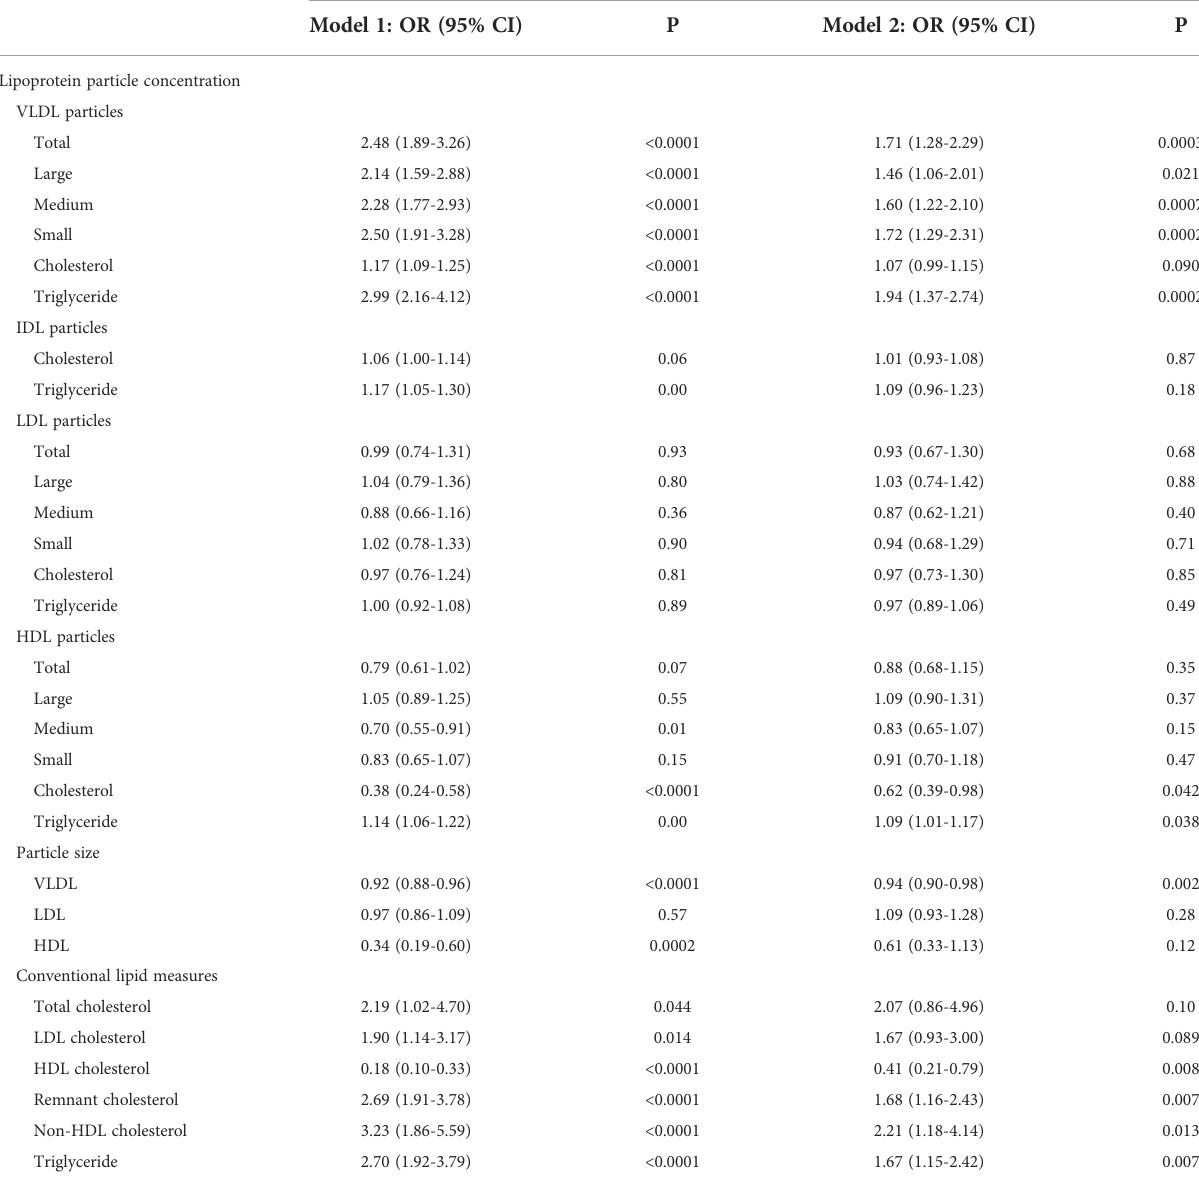
TABLE 4 Association of WHR obesity with lipid